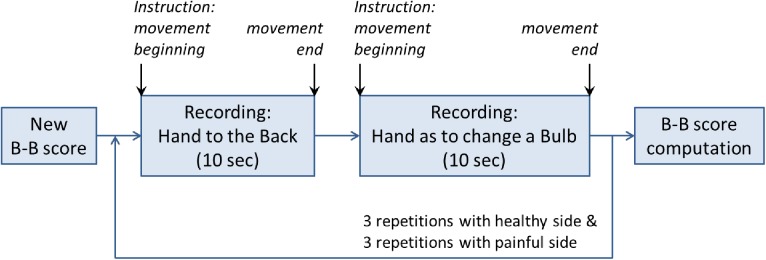
Schema of the application steps for the recording of a B-B score.From: Pichonnaz C, Duc C, Gleeson N, Ancey C, Jaccard H, Lecureux E, et al. Measurement Properties of the Smartphone-Based B-B Score in Current Shoulder Pathologies. Sensors (Basel). 2015;15(10):26801-17.